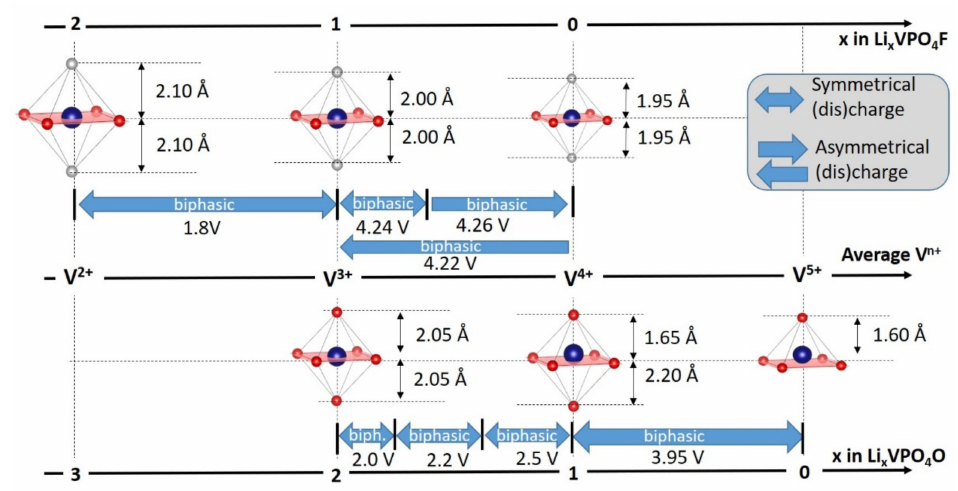
(Figure 13) while Li + ions are distributed between two 8f Wyckoff sites half occupied in LiO 3 F 2 environments.